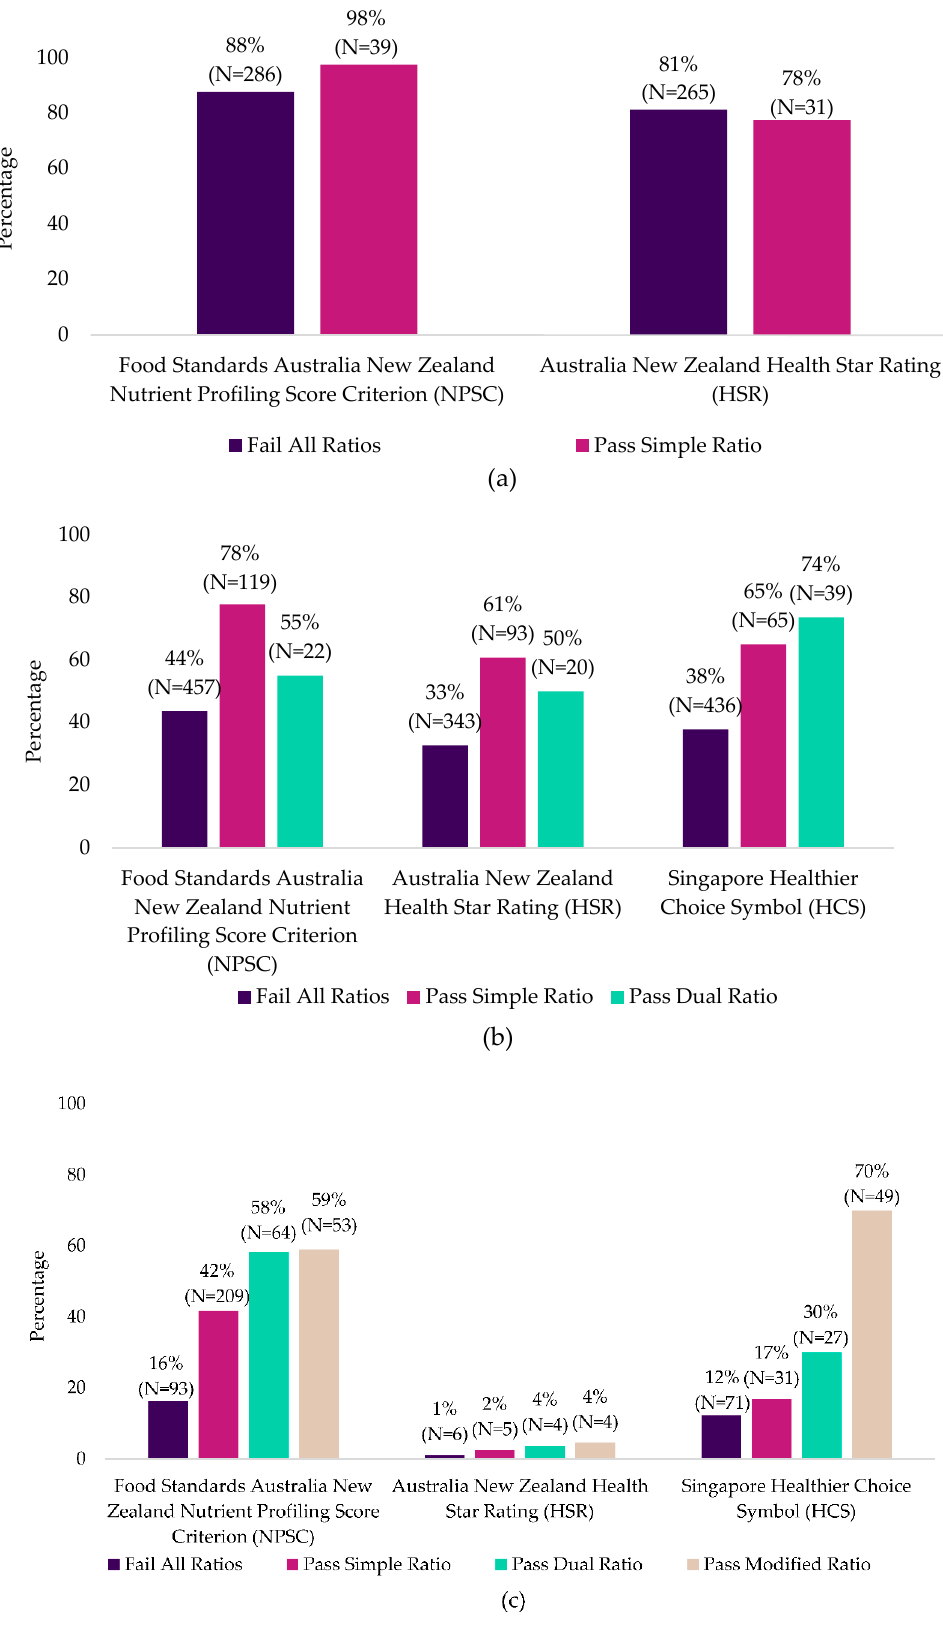
Figure 5. Percentage of carbohydrate-based ( a ) RTD beverages from Mintel Australia ( b ) RTD beverages from Mintel Asia and ( c ) powdered beverages from Mintel Asia that passed or failed the three metrics and met the respective national nutrient product models as a nutritious product. 3.3. Proportion of Whole Grain Product Choices and Their Association with the Carbohydrate Metrics There was a greater proportion of whole grain food choices from Mintel Australia (31.6%) compared to Mintel Asia (18.8%). There were very few whole grain beverage choices in both Mintel Australia (1.6%) and Mintel Asia (3.7%) (Table S2). When foods from the Mintel Database were analysed, there was a significant association between adherence to the three metrics and availability of whole grain product variants ( p < 0.001) (Table S3). When beverages from the Mintel Database were analysed, there was also a significant association between adherence to the simple and dual metrics and the availability of whole grain product variants ( p < 0.001). However, this was no longer observed with the modified ratio ( p = 0.070) (Table S4). 3.4. Comparison of Data from AFCD-1 and Mintel Australia A comparison of products sold in Australia between the two databases showed similar results, whereby breads (unfilled), cold cereal and hot cereal had a high adherence and savoury biscuits had a moderate adherence to all of the metrics (Figure 2a,b). Several differences were observed, including cereal and fruit bars to be of high adherence to the simple ratio, and moderate adherence to the dual and modified ratios in Mintel Australia but not in AFCD-1. This is due to the absence of several types of cereal and fruit bars from the AFCD-1 (e.g., cold press bars, meal replacement bars). Additionally, instant pasta and rice had a moderate adherence to all three metrics in Mintel Australia but not in AFCD-1, potentially because the product sampling for AFCD-1 was older. Figure S1 shows the mean free sugars content of products within a sub-category from Mintel Australia versus the free sugars content of the same sub-category from AFCD-1. The two-tailed t-test conducted showed that there was no significant difference between the free sugars content imputed for the Mintel Database and the free sugars content of the respective product sub-categories in the AFCD-1 ( p = 0.33). The NSE coefficient of the imputation was analysed to be 0.83. These results verify the concurrency of the free sugars content used in the analysis of products from both databases. 4. Discussion In this study, the adherence of carbohydrate-based packaged foods and beverages to three variations of the carbohydrate metrics characterised by ratios of total carbohydrates, dietary fibre